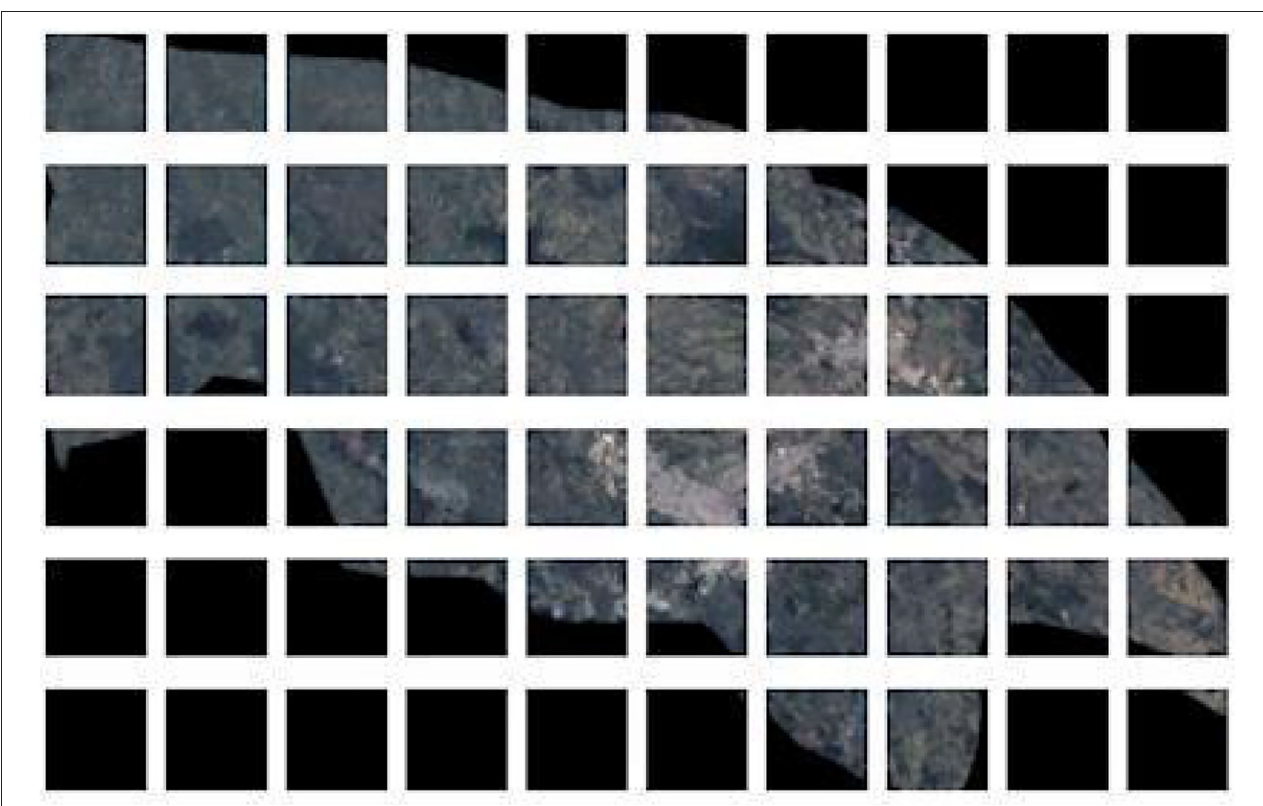
FIGURE 4 | Patch generation. Satellite image of municipality of Popayán divided into patches of images of 256 × 256 pixels used to generate the predictions of features found in each